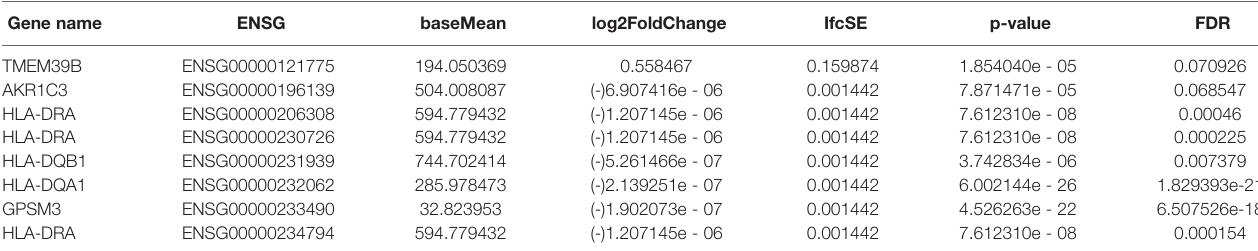
TABLE 2B | Gene expression signi fi cantly up or down-regulated in APS-1 patients ’ Tregs ’ compared with healthy controls (FDR<0.1).